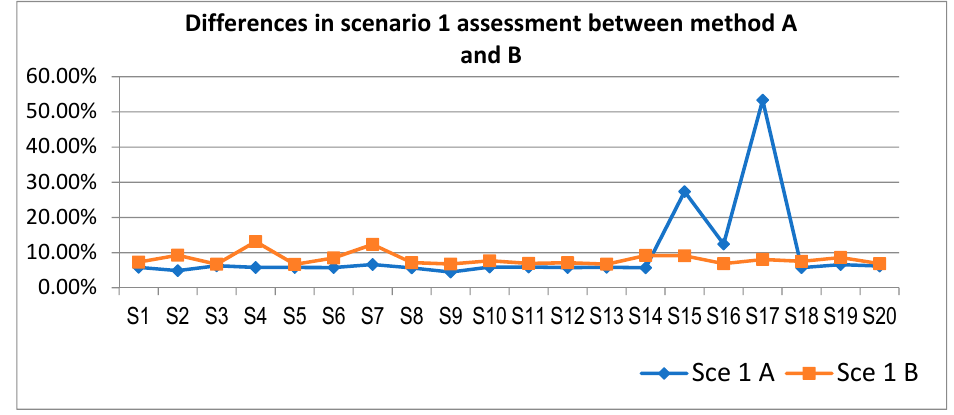
Figure 9. Differences in scenario 1 between multi-actor multi-criteria analysis (method A) and multi-actor multi-criteria analysis with the weight of stakeholder involvement (method B).